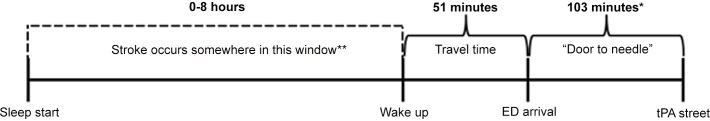
Time sequence from sleep start to tissue-type plasminogen activator (tPA) initiation for acute wakeup stroke patients in the micro-simulation model.*Door-to-needle time includes additional 30 minutes for performing and interpreting MRI. **Base-case assumption for true stroke onset during sleep is based on a uniform probability between 0–8 hours. Sleep durations of 4 and 6 hours, and alternative skewed beta distributions used in sensitivity analyses.